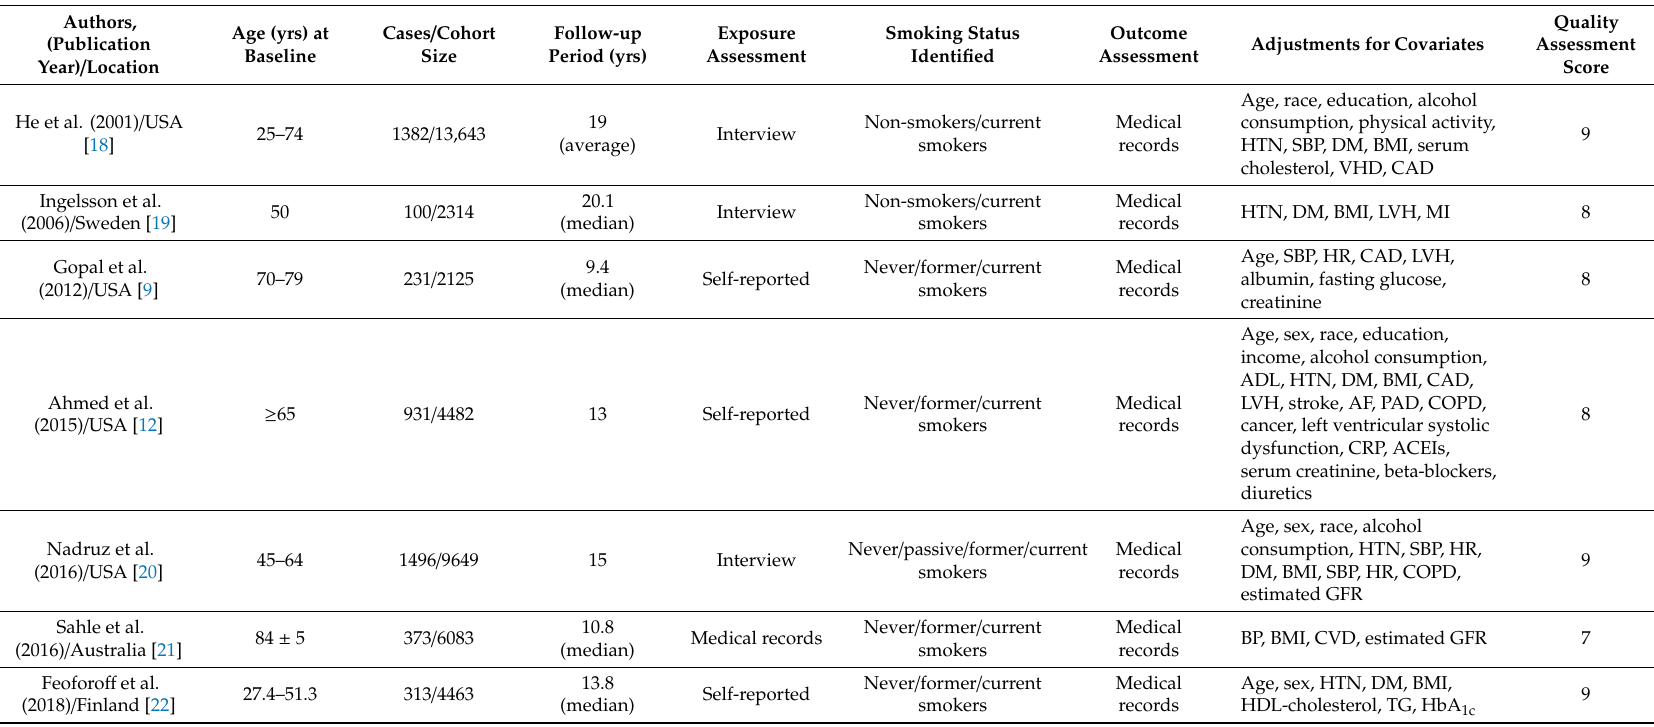
Table 1. Characteristics of studies